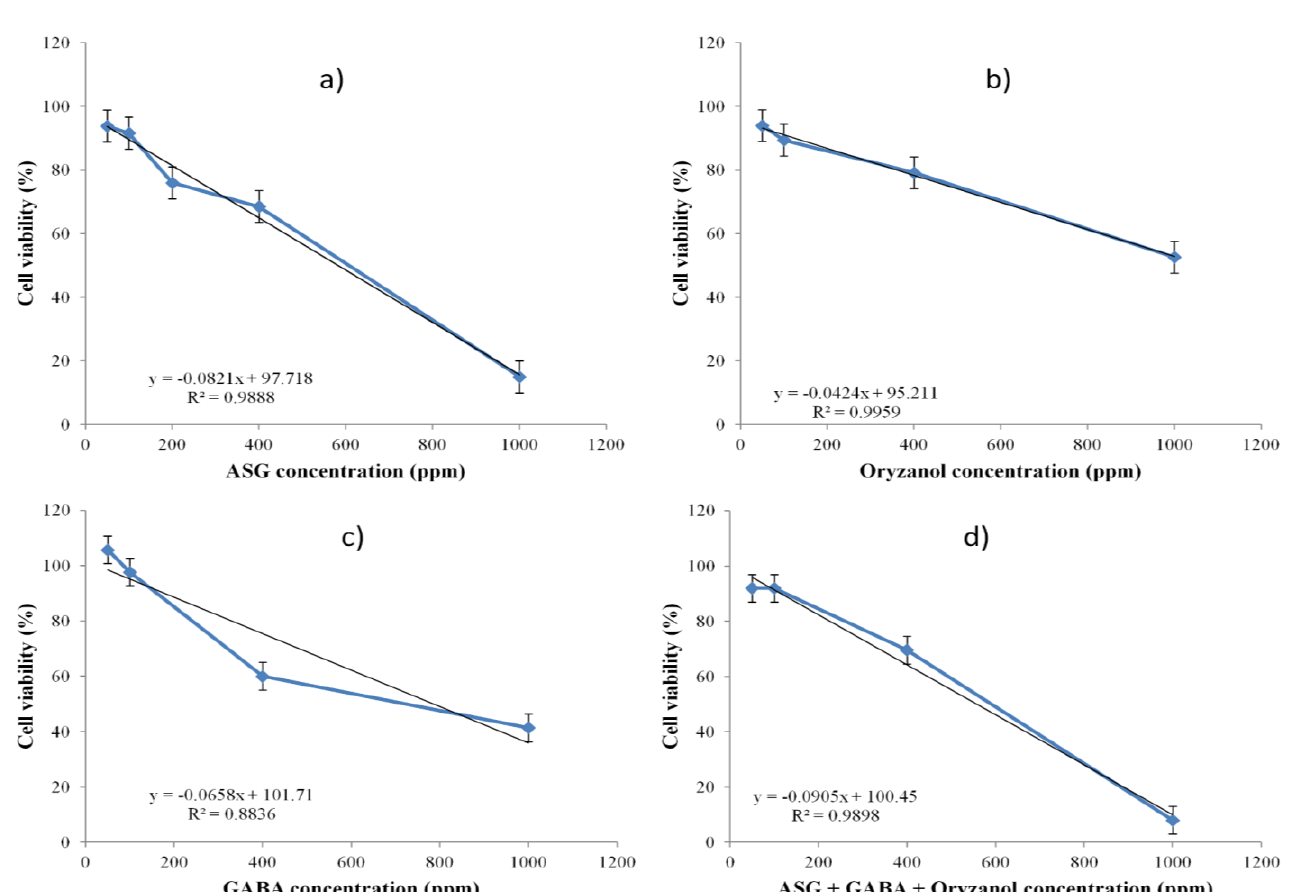
Figure 1. Effects of ( a ) acylated steryl glycoside (ASG), ( b ) oryzanol, ( c ) gamma amino butyric acid (GABA), and ( d ) ASG + GABA + Oryzanol, on HEP-G2 cell viability. HEP-G2 cells treated with ASG, GABA and oryzanol were incubated for 24 h, after which cell viability was determined. Each data point and the error bars on the graph represent mean ± standard deviation ( n = 4). Linear regression analyses (represented by the black lines and equations on each graph) show a strong correlation between the concentrations of the extracts and cell viability data obtained from the experiment, as suggested by the high R 2